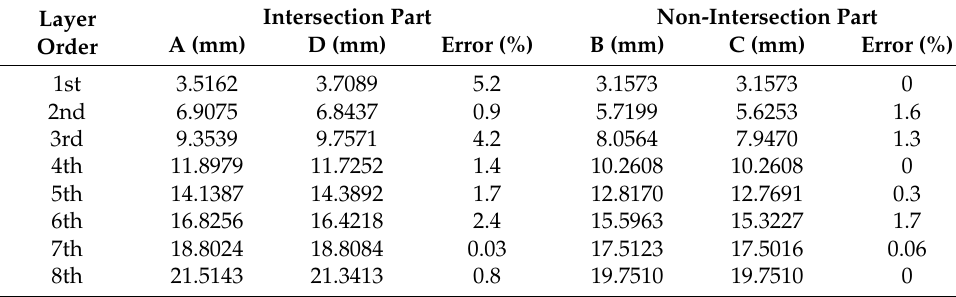
Table 2. Comparison of intersections and non-intersections including error rates.